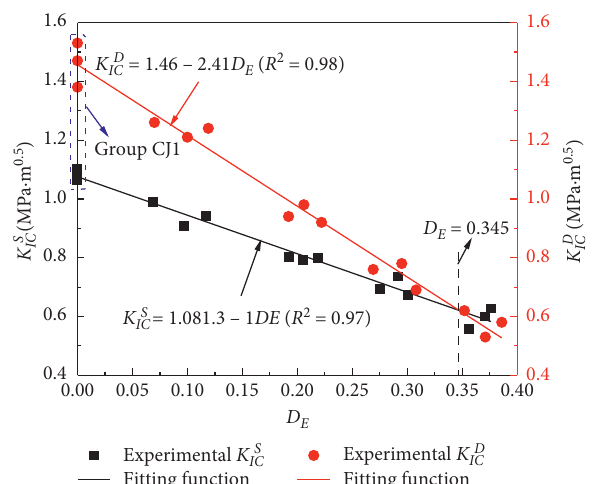
Figure 9: Relationship between the fracture toughness and DE. Note: In Figure 9, when DE is 0, it corresponds to the experimental data of group CJ1. The meaning represented in Figures 13 and 14 are the